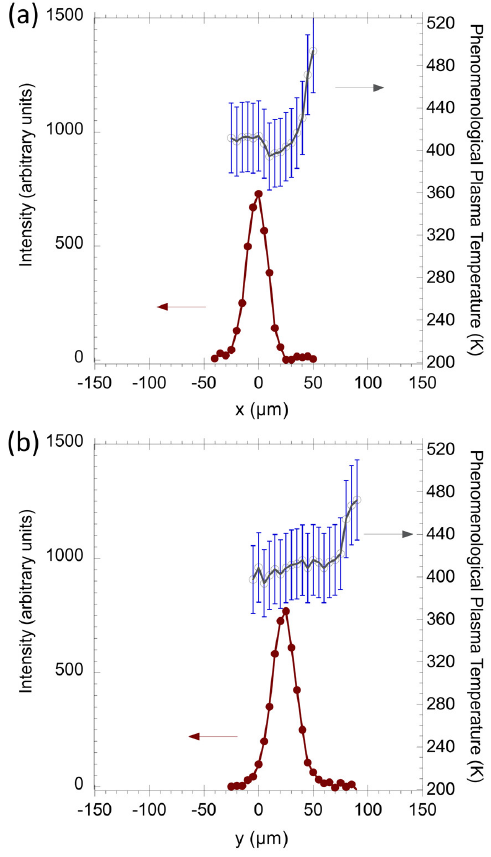
Figure 10. The signal intensity of the NO (A 2 Σ –X 2 Π ) (0–0) emission at 226 nm and the derived spatial